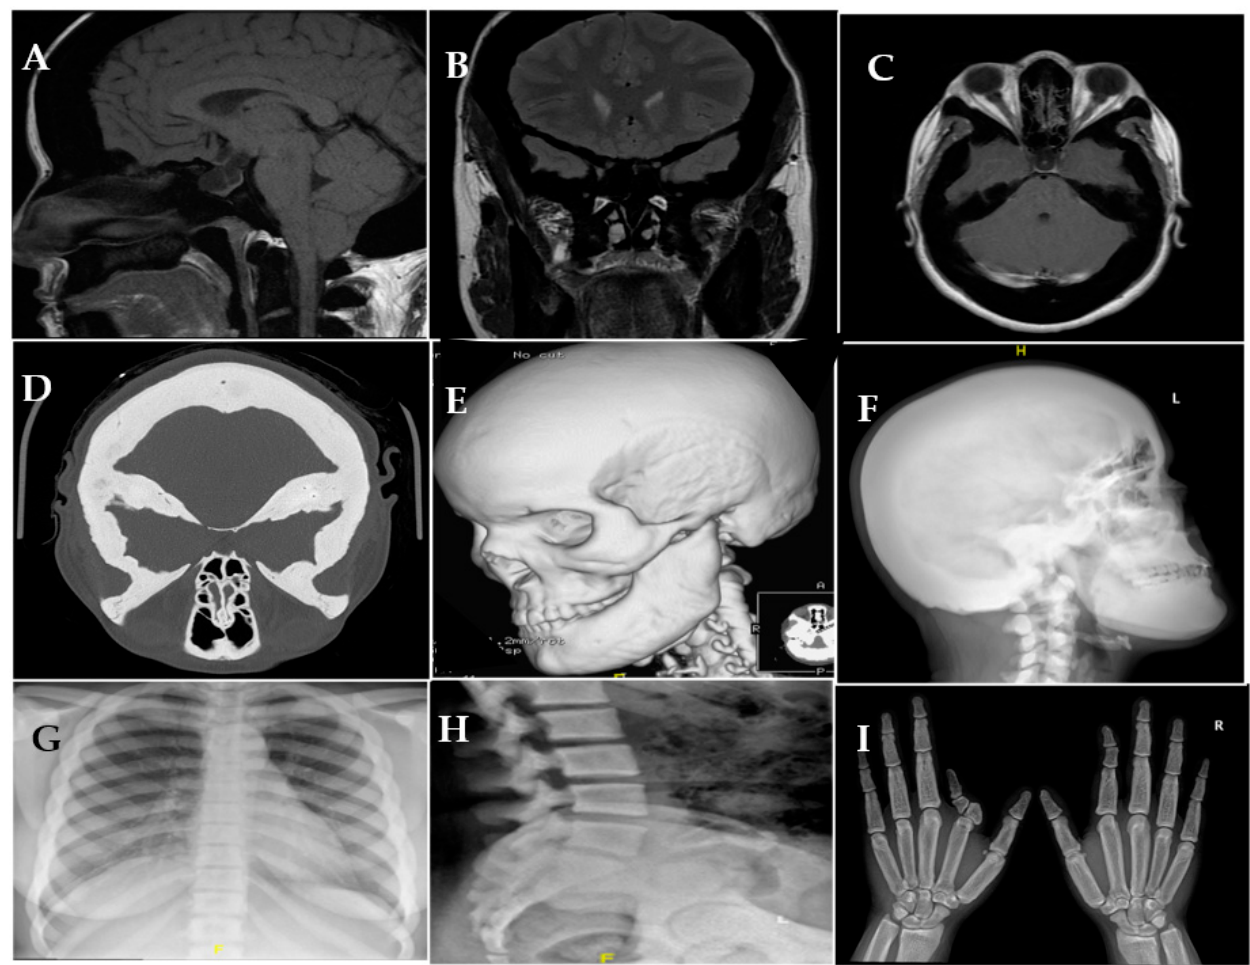
Figure 2. ( A ) Magnetic resonance imaging (MRI) T1 sagittal view: Enlarged sella turcica filled with CSF. Normal appearing pituitary gland at base of sella. Diffuse thickening of the osseous structures. tonsillar ectopia, cerebellar tonsillar herniation 8 mm below foramen magnum. ( B ) MRI: Severe narrowing of the skull base foramina including optic canals with optic nerve compression. ( C ) MRI T1 axial view: Loss of bone marrow fat and increased bone thickness. ( D ) Computed tomography (CT) bone window: Severe diffuse osseous thickening. ( E ) 3-D CT scan of the brain: Severe diffuse thickening of the osseus structures of the skull, facial bones. ( F – I ) X-ray bone survey: Generalized increase in bone density with diffuse cortical thickening and deformed left second metacarpal